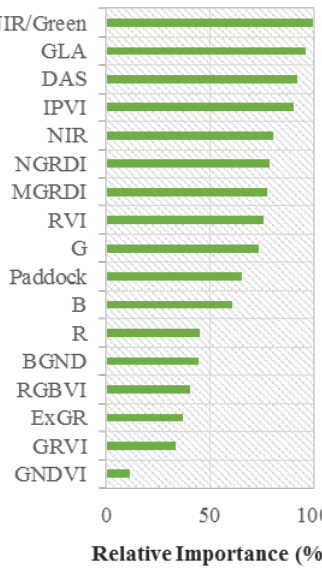
Figure 3. Relative importance of the variables as measured by the Variable Importance metric in the Random Forest algorithm. The predicted pasture biomass maps for our study area for four dates – 20 th May, 15 th June, 11 th July, and 10 th August 2019, are shown in Figure 4. These maps show spatio-temporal changes in pasture biomass for all paddocks, which were in parity with expected changes in pasture vegetation, as driven by forage development and management operations.